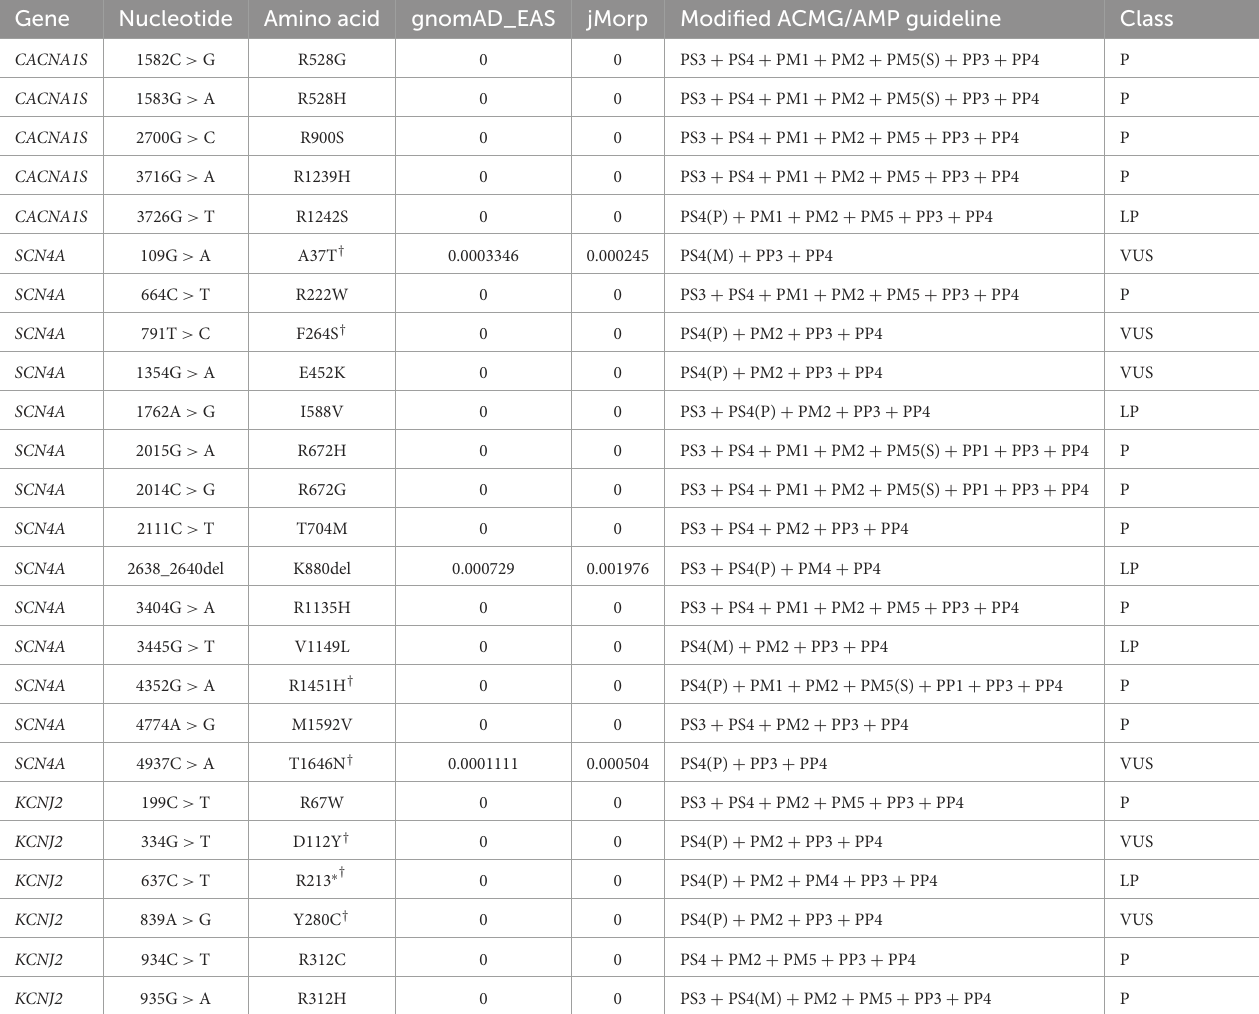
TABLE 1 All variants detected from 34 Japanese patients with PP. Gene